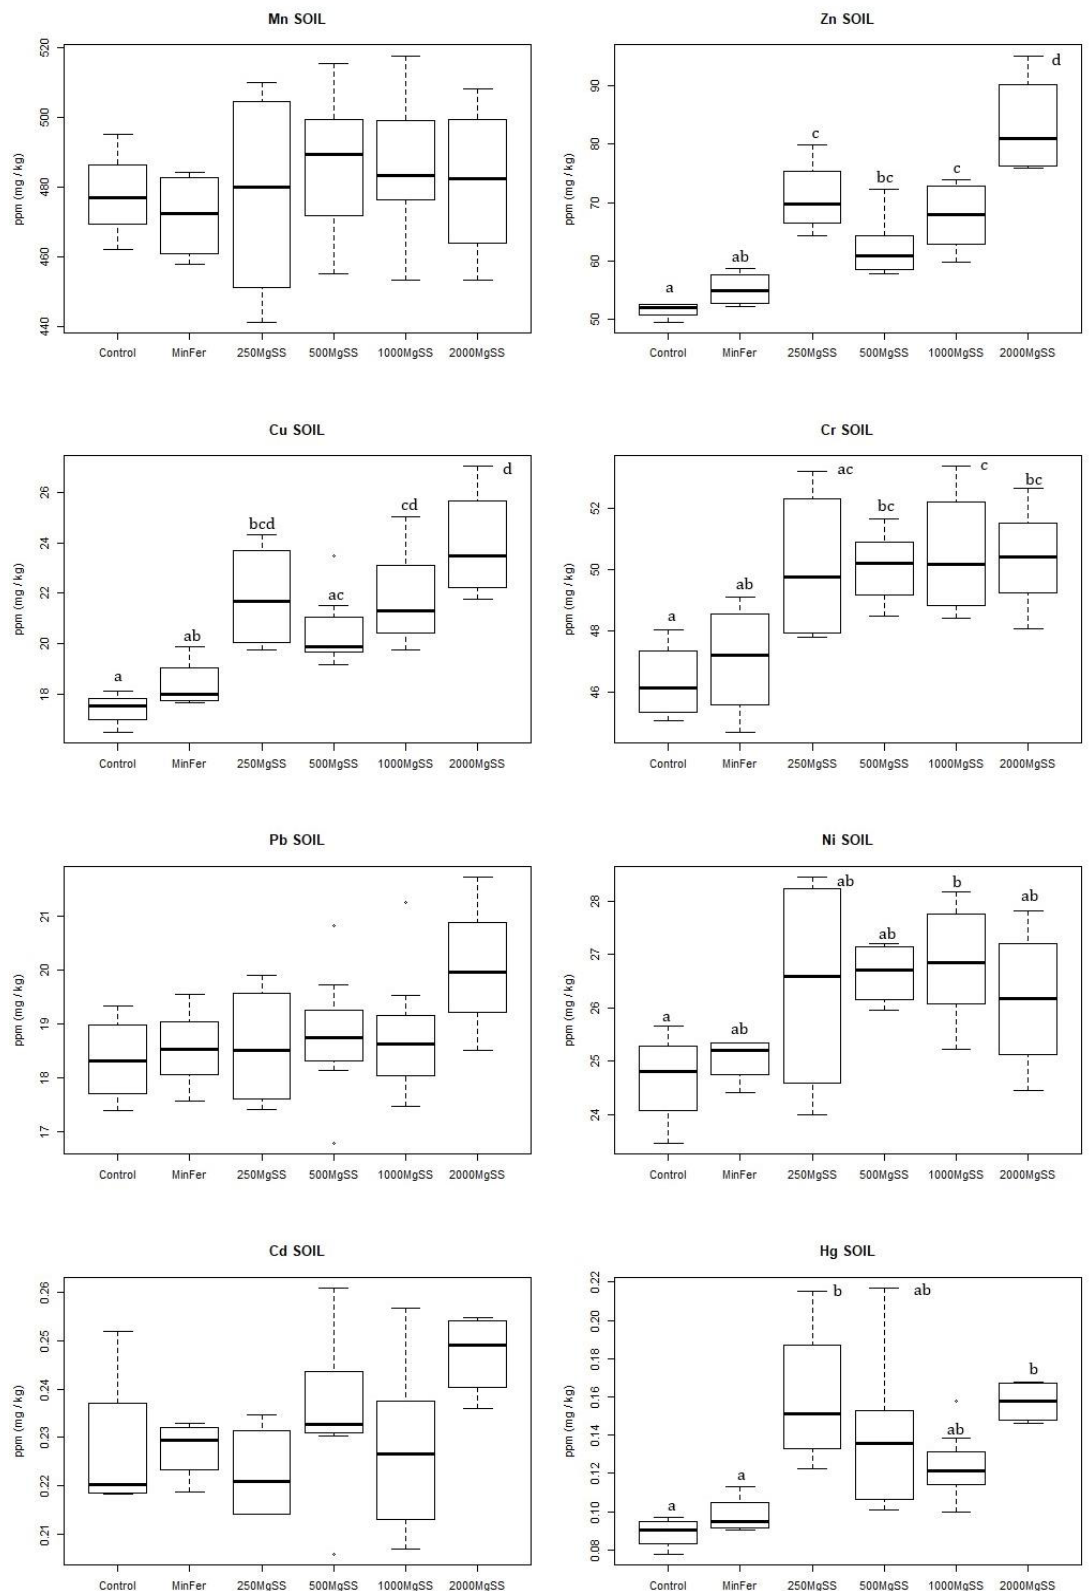
Figure 1. Box-and-whisker plot indicating different homogeneous groups in the multiple comparison Scheme (0–30 cm). Values showing the same letter belong to the same homogeneous group according to Tukey’s test ( p < 0.05).